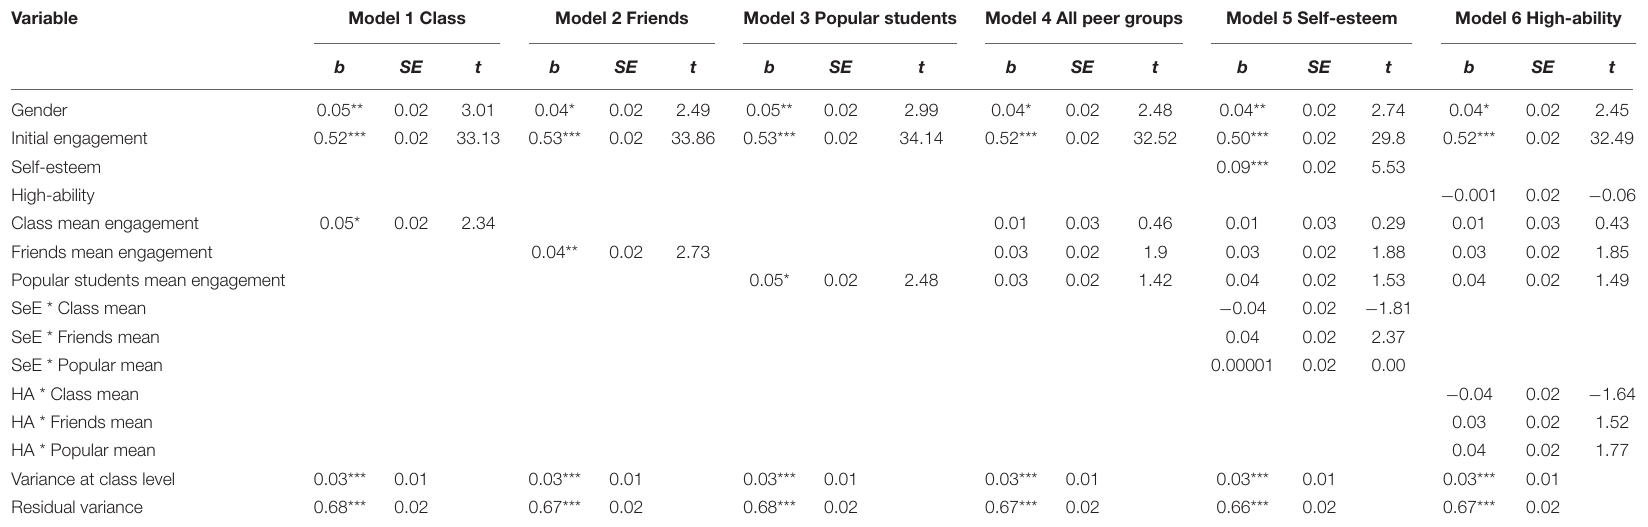
TABLE 4 | Multilevel models of peer group effects on emotional engagement ( N =